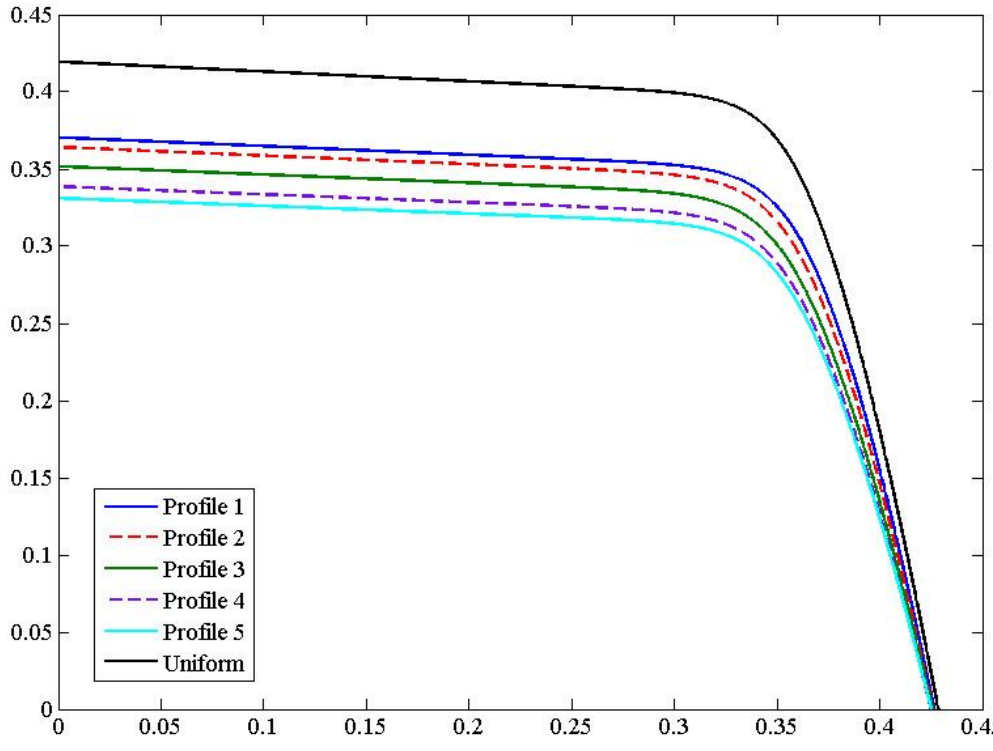
Figure 13. I-V curves given by the MATLAB array modelling for several illumination profiles.